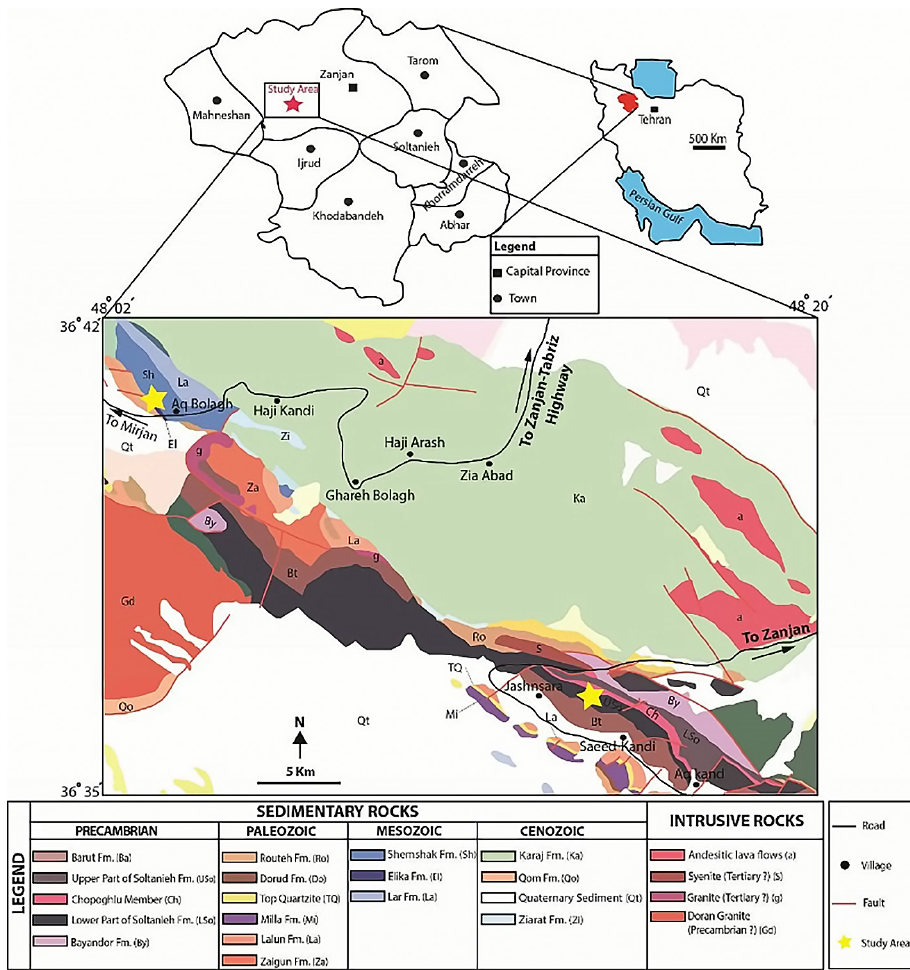
Figure 1. The geological map and geographical location of the study area (geological map modified from Hajian and Zahedi (2004))